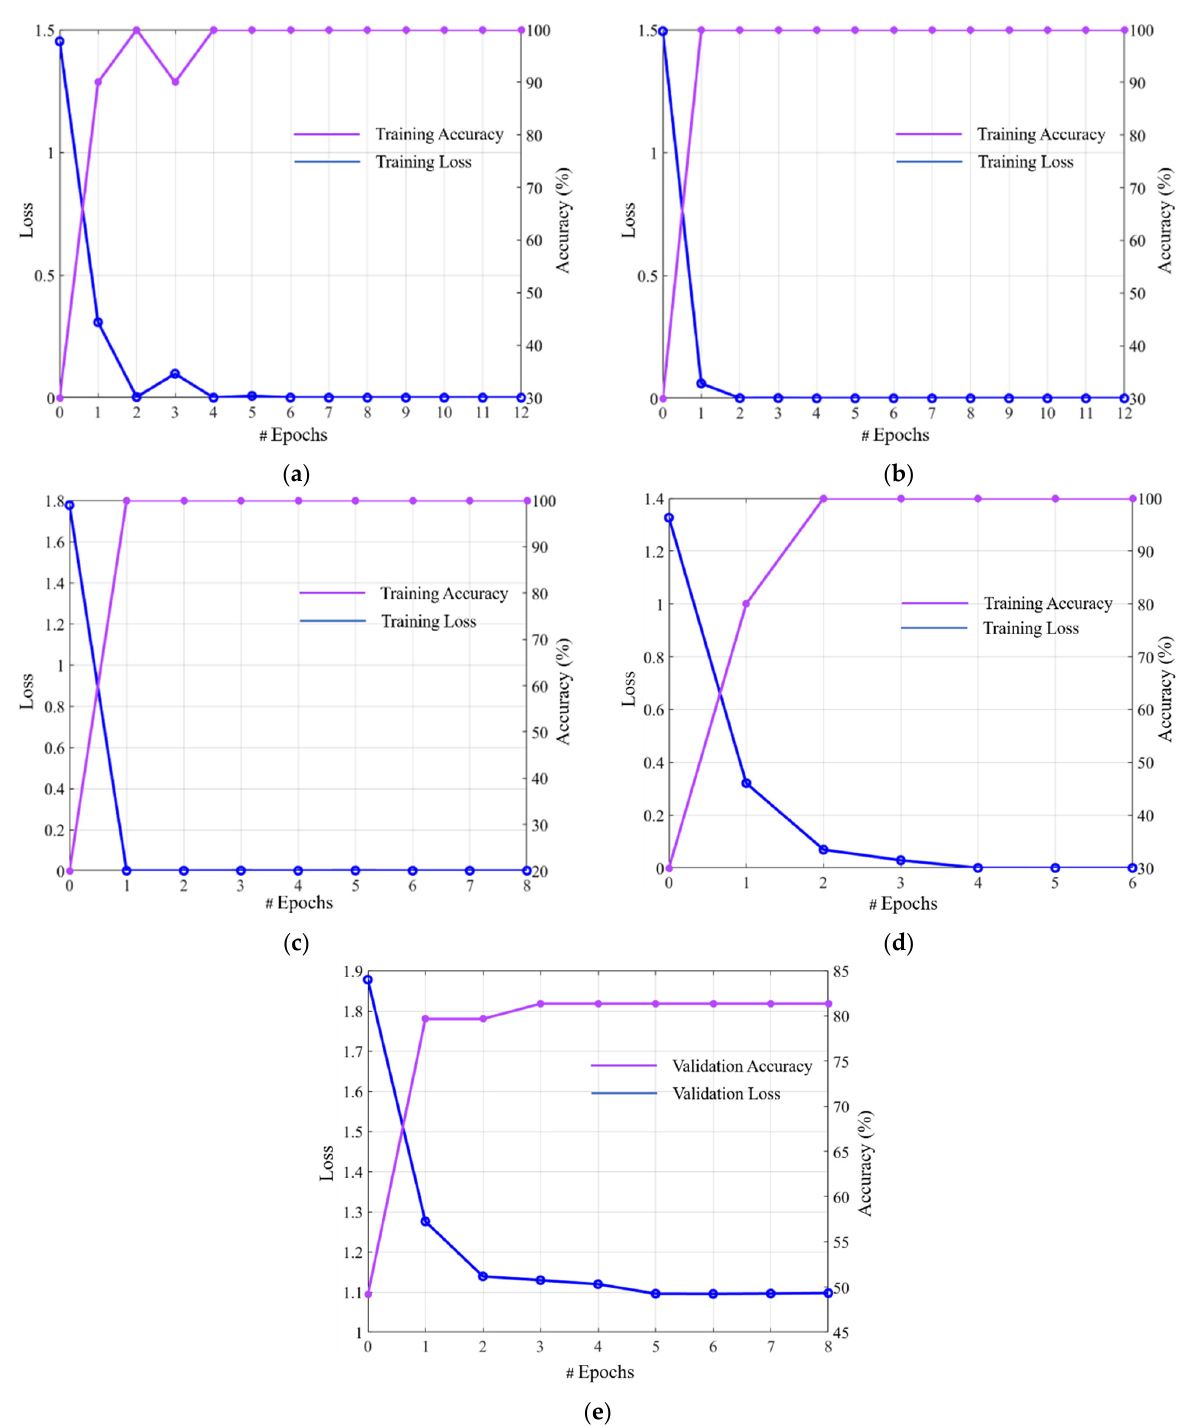
Figure 8. Plots for training losses and training accuracies: sequential training of ( a ) modified DenseNet-201, ( b ) modified ResNet-50, ( c ) SCN, ( d ) DRE-Net (end-to-end training), and ( e ) plots for validation losses and validation accuracies of SCN of ( c ).